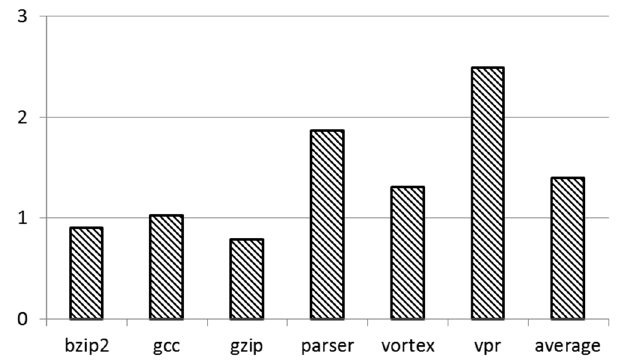
Figure 3. Baseline performance in IPC.